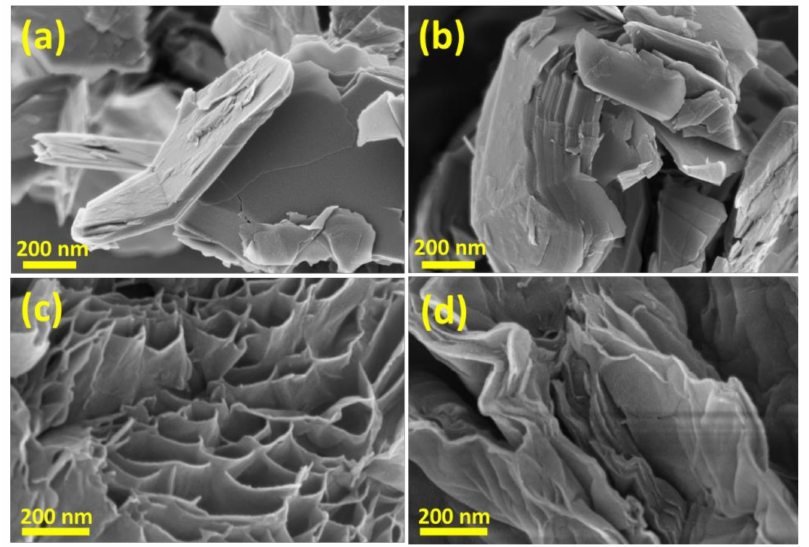
Figure 2. The SEM micrographs of the KS6 ( a ), SFG6 ( b ), GO-KS6 ( c ), and GO-SFG6 ( d